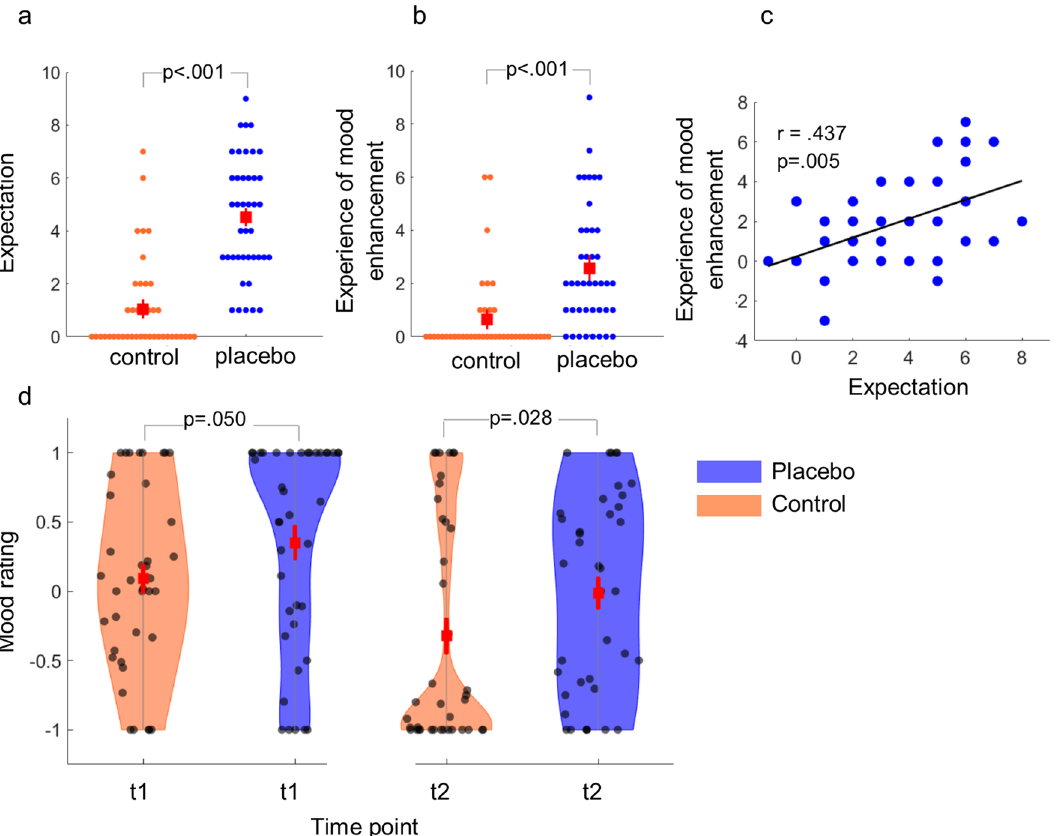
Figure 2. Expectation, experience, and mood ratings. ( a , b ) Positive treatment expectation and experience ratings. Both expectation and experience ratings increased in the placebo (blue) condition relative to the control (orange) condition. ( c ) Correlations between differences in expectation and experience ratings. Higher expectations of a positive mood change predicted higher experience of a positive mood change. ( d ) VAS mood ratings. Participants demonstrated a higher mood rating in the placebo condition relative to the control condition at both time points. Data are range normalized and baseline corrected. Mean (red square) and s.e.m. are shown in the center of each subplot.